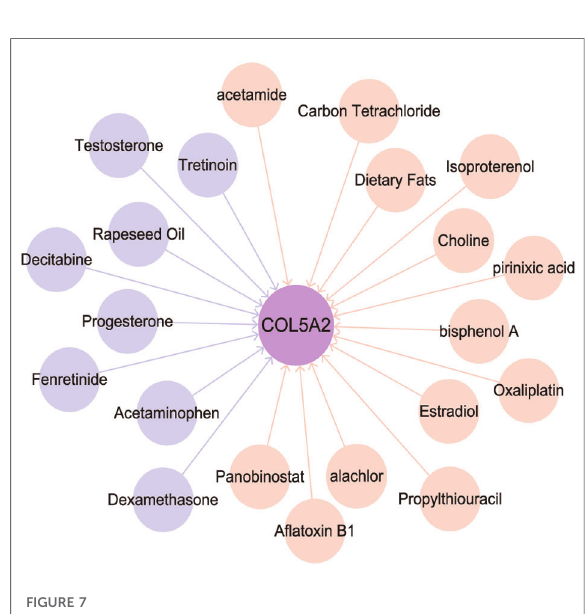
FIGURE 6 The relative expression of COL5A2 . Stars represent statistical signi fi cance of T -test: ***<0.001; ****<0.0001.